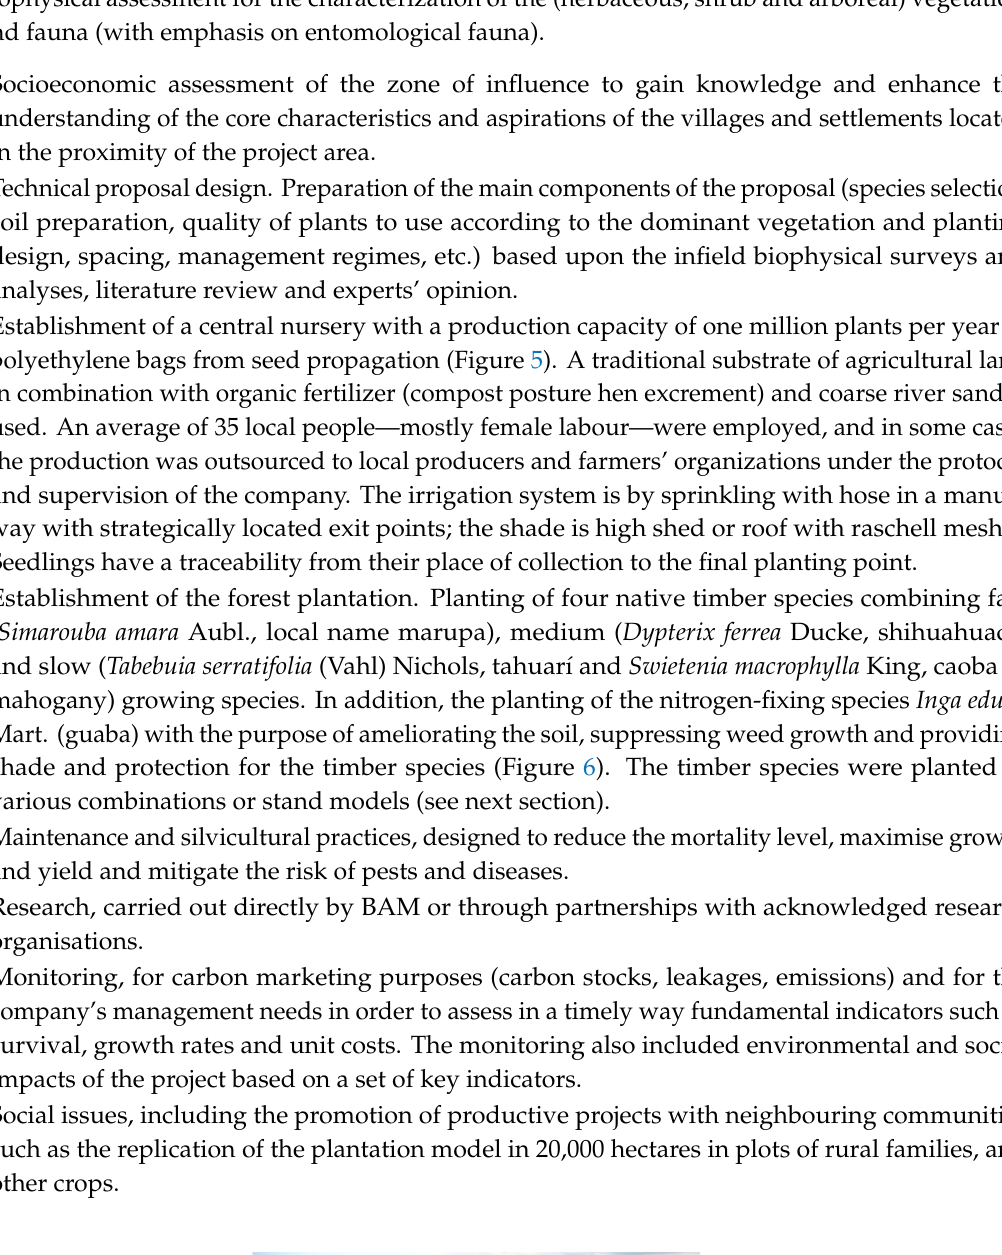
Figure 6. Planting Inga sp. and timber species. 3. Project Implementation 3.1. Technical Aspects 3.1.1. Species Selection The selection of the timber species for plantation was based on local consultation with technical specialists and as a result of site visits to surrounding areas. Information about successful tree species from these sources informed the company’s decisions about which species to plant or favour in case of natural regeneration. The selection process was in a large part based on local knowledge about allelopathy, providing information on species interaction and the interplanting regime. Accordingly, information regarding growth rates, spacing, and other inputs were strongly influenced by local knowledge about behaviour of these species in local conditions. The seeds were all sourced from the remnant native forests and forest reserves in Ucayali, except for mahogany, which was sourced from other areas because it was completely harvested from the region many years ago. Each tree from which seeds were collected was documented and geo- referenced using GPS. Additionally, arrangements were made with local communities living in the vicinity of these seed trees to ensure the seed trees are protected for subsequent seed harvest. A critical aspect of the model is the use of Inga edulis , a leguminous fruit tree that produces guaba, a locally consumed fruit with high demand. This tree was included because of its nitrogen- fixing characteristic in order to enhance the soils in the highly degraded lands of the project area,